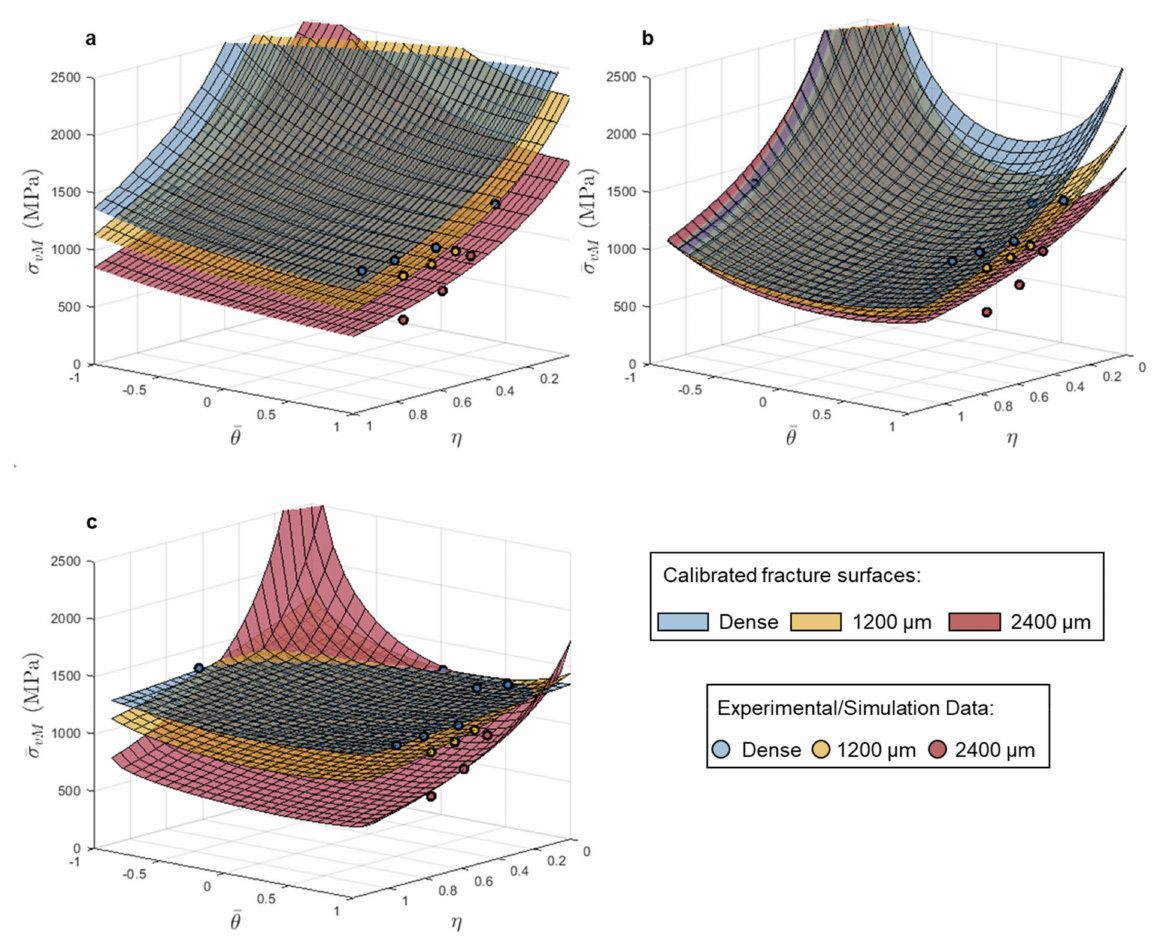
Figure 7. Calibrated ( a ) maximum stress, ( b ) Mohr–Coulomb, and ( c ) Hosford–Coulomb fracture loci in stress triaxial- ity vs. Lode angle parameter vs. equivalent stress space for Ti-6Al-4V using dense, 1200 µ m pore, and 2400 µ m pore